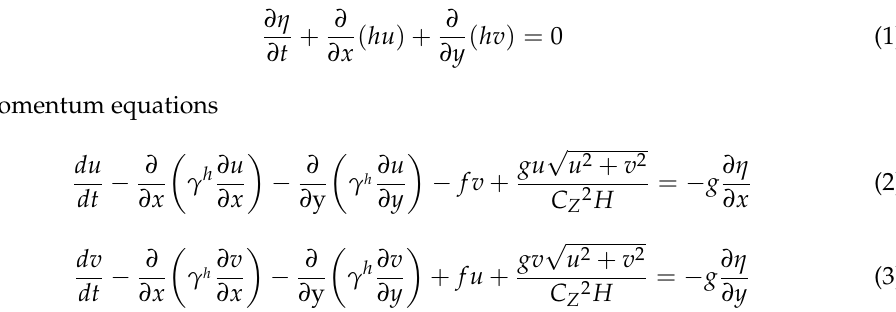
Figure 3. Calculation ranges and grid distribution maps of the models. The study area is located along the northern coast of the Yellow Sea (see Figure 1), where tidal currents play a dominant role in various flow components. The three-dimensional Navier–Stokes equations for the free-surface flow of incompressible fluid in the Cartesian coordinate system were used for description; on this basis, the horizontal momentum equations and the continuity equation for the three-dimensional shallow water form were integrated in the range H = η + h to obtain the following depth-averaged two-dimensional shallow water continuity